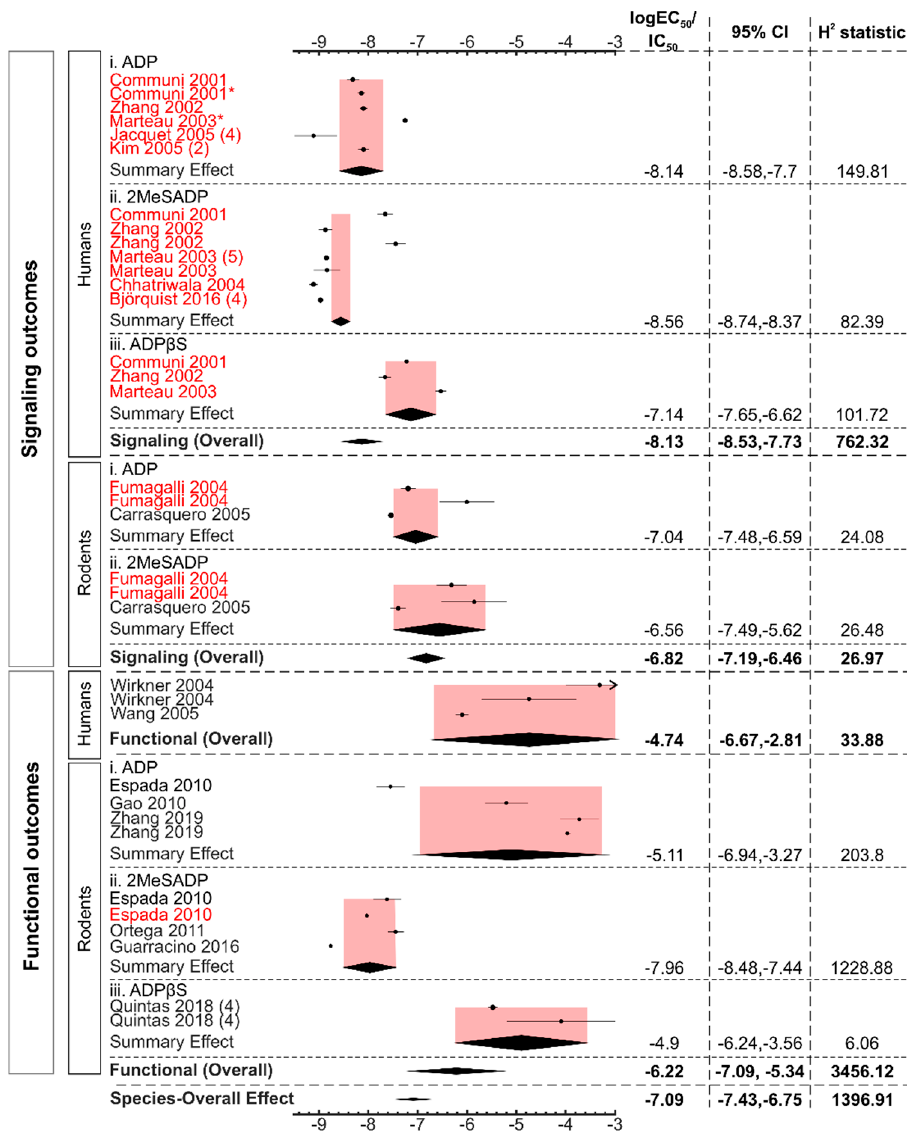
Figure 8. Subgroup analysis based on the species of the P2Y13 receptor. The forest plot represents the log 10 EC 50 values in different P2Y13 species (humans and rodents) to generate a P2Y13-mediated response. The black diamonds and the pink shaded regions represent the overall effect size and the 95% confidence interval. The study names in “red” were conducted in the heterologously-expressed P2Y13 receptor. All the studies were of sample size, n = 3, unless otherwise stated in parentheses. The studies marked in * had multiple datasets of the same agonist and outcome in the individual study and were averaged, with Communi, 2001, having 2 datasets and Marteau, 2003, having 3 datasets.